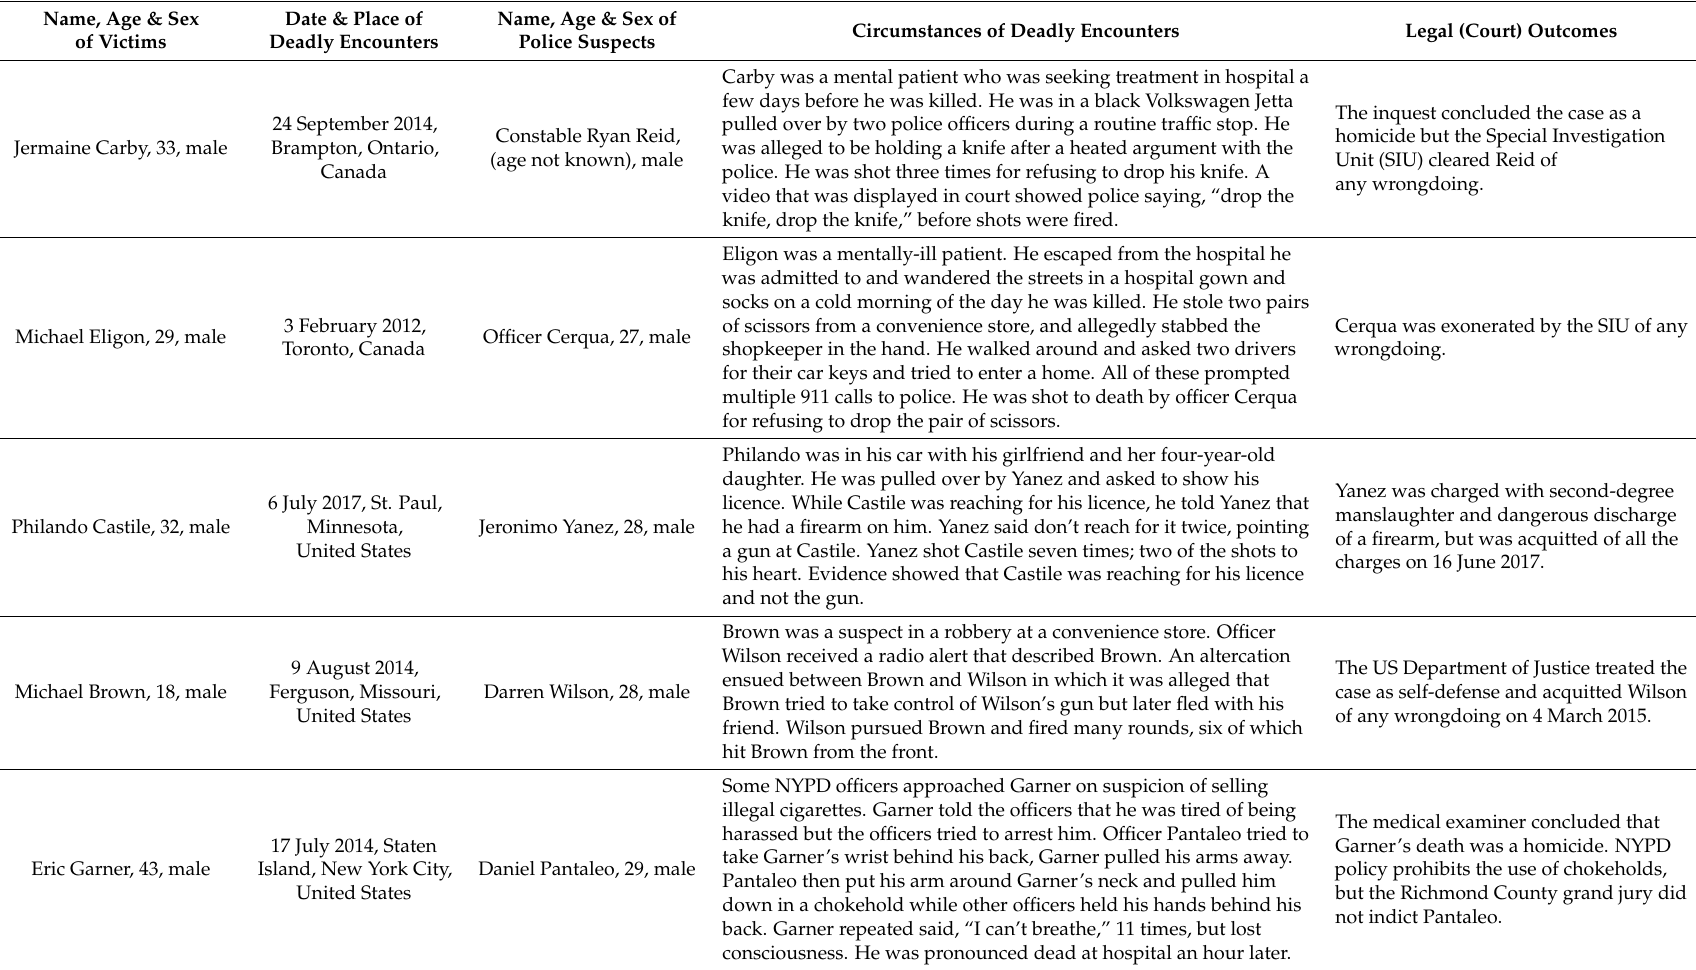
Table 1. The situational characteristics and legal outcomes of selected deadly encounter